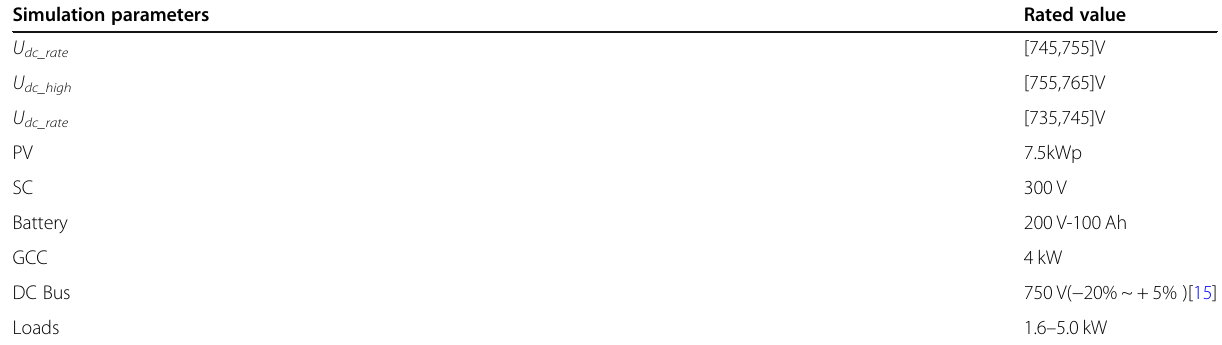
Table 2 Simulation parameters of household-level EPR